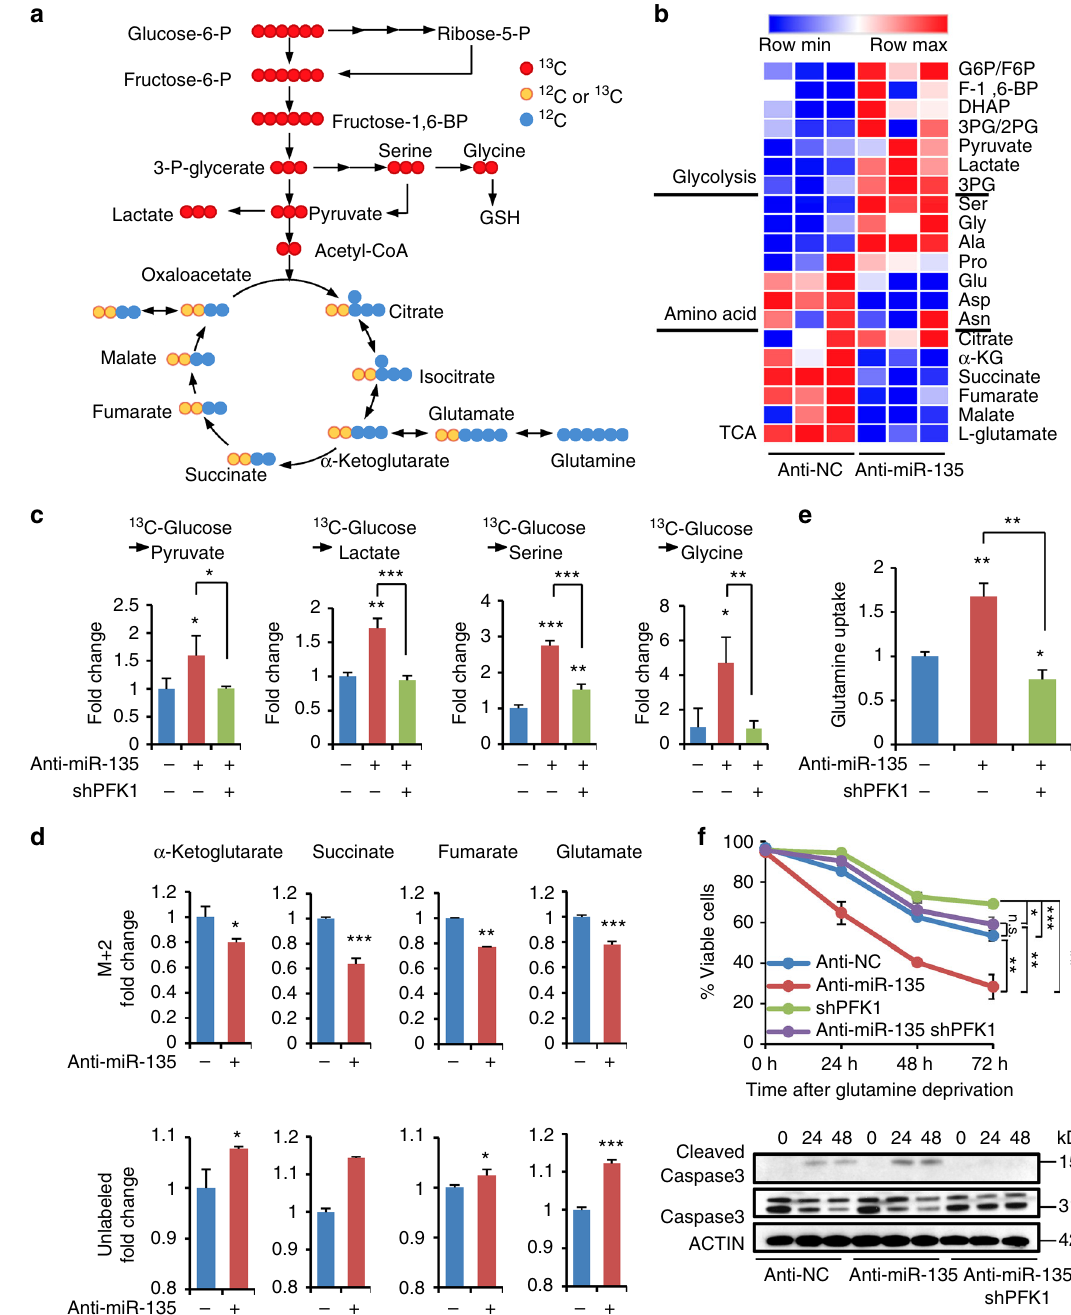
Fig. 6 miR-135 knockdown leads to increased glutamine dependence. a Schematic representation of 13 C- glucose metabolism. b Heatmap of signi fi cantly changed labeled metabolites in glycolysis, amino acids and tricarboxylic acid cycle in control and miR-135 knockdown MIA PaCa-2 cells analyzed by LC- MS. c Labeled pyruvate, lactate, serine and glycine were analyzed in control (anti-NC), miR-135 knockdown (anti-miR-135) and miR-135/PFK1 double knockdown MIA PaCa-2. Fold change is calculated by the labeled metabolites normalized to control MIA PaCa-2 cells. Each value represents mean ± SD in three independent experiments. * p < 0.05, ** p < 0.01, *** p < 0.001, Student ’ s t test. d Labeled and unlabeled α -ketoglutarate, succinate, fumarate, and glutamate were analyzed in control (anti-NC) and miR-135 knockdown (anti-miR-135) MIA PaCa-2 cells by using LC-MS. Fold change is calculated by the labeled or unlabeled metabolites divided by pool and normalized to control MIA PaCa-2 cells. Metabolite data are shown as mean ± SD in three independent experiments. * p < 0.05, ** p < 0.01, *** p < 0.001, one-tailed Student ’ s t test. e Control (anti-NC), miR-135 knockdown (anti-miR-135) and miR- 135/PFK1 double knockdown MIA PaCa-2 cells were cultured in complete medium for 24 h. Glutamine uptake was measured using the Nova Biopro fi le 100 analyzer. f Control (anti-NC), miR-135 knockdown (anti-miR-135), shPFK1 and miR-135/PFK1 double knockdown MIA PaCa-2 cells were cultured in glutamine-free medium for indicated time points. Cell viability was assessed by Trypan blue exclusion. Each value represents mean ± SD in three independent experiments. * p < 0.05, ** p < 0.01, *** p < 0.001, Student ’ s t test. Cells were lysed and immunoblotting was performed with